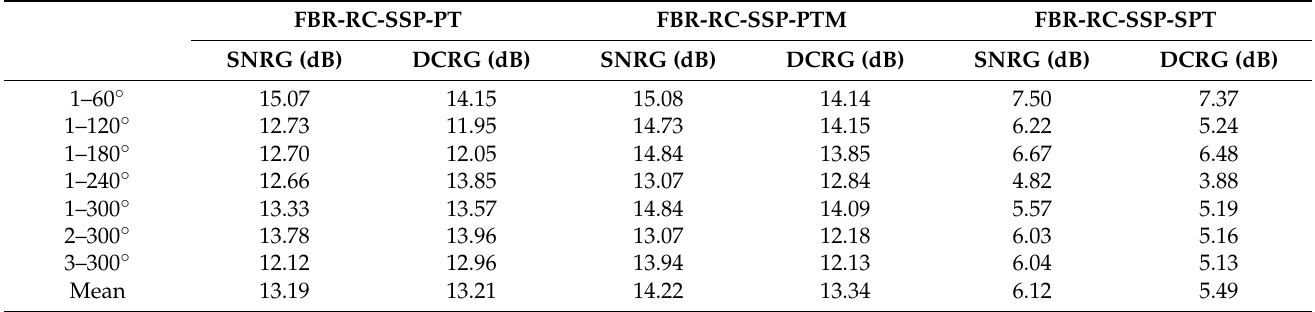
Table 2. SNRGs and DCRGs of simulated UGW signals processed by FBR-RC-SSP.